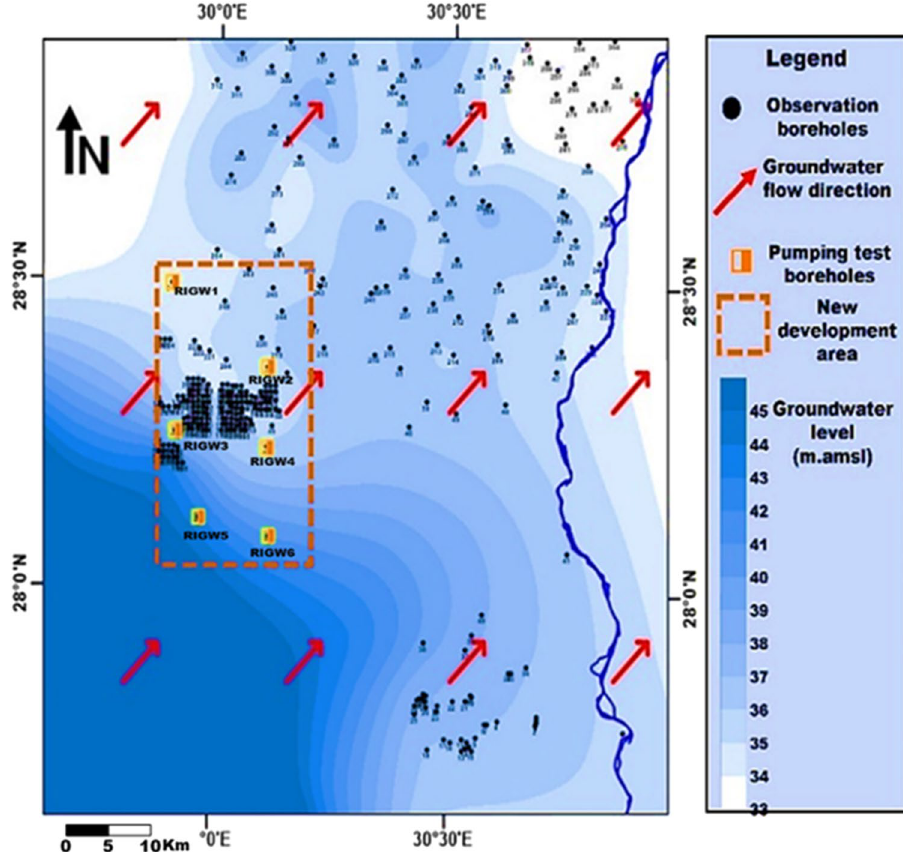
Fig. 4 Potentiometric surface of groundwater levels and the outline of the new development